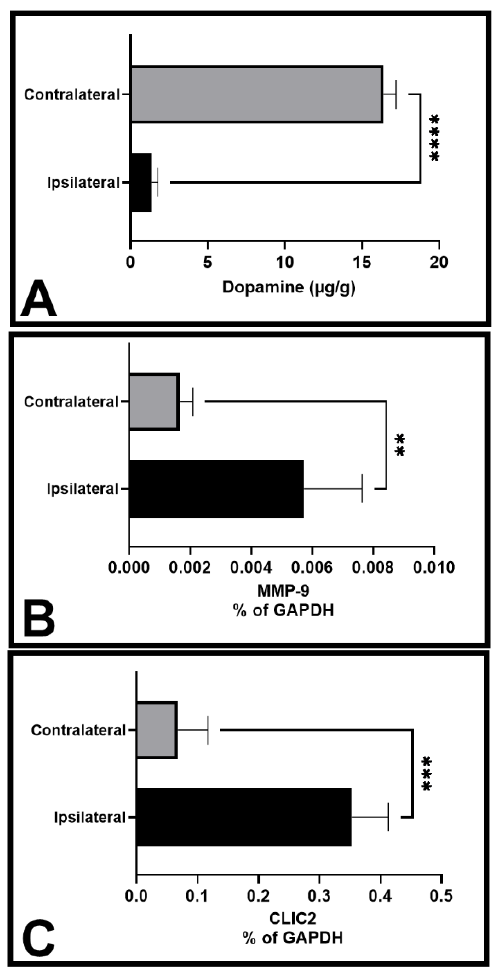
Figure 1. Expressional changes of CLIC2 and MMP-9 in Parkinson’s-modeled rat brain. Infusion of 6-OHDA decreased the contents of dopamine (DA) in striatum ( A ) and increased mRNA expression of MMP-9 ( B ) and CLIC2 ( C ). ** p < 0.01, *** p < 0.001, and **** p < 0.0001 indicate significant difference between the two ipsilateral and contralateral sides.